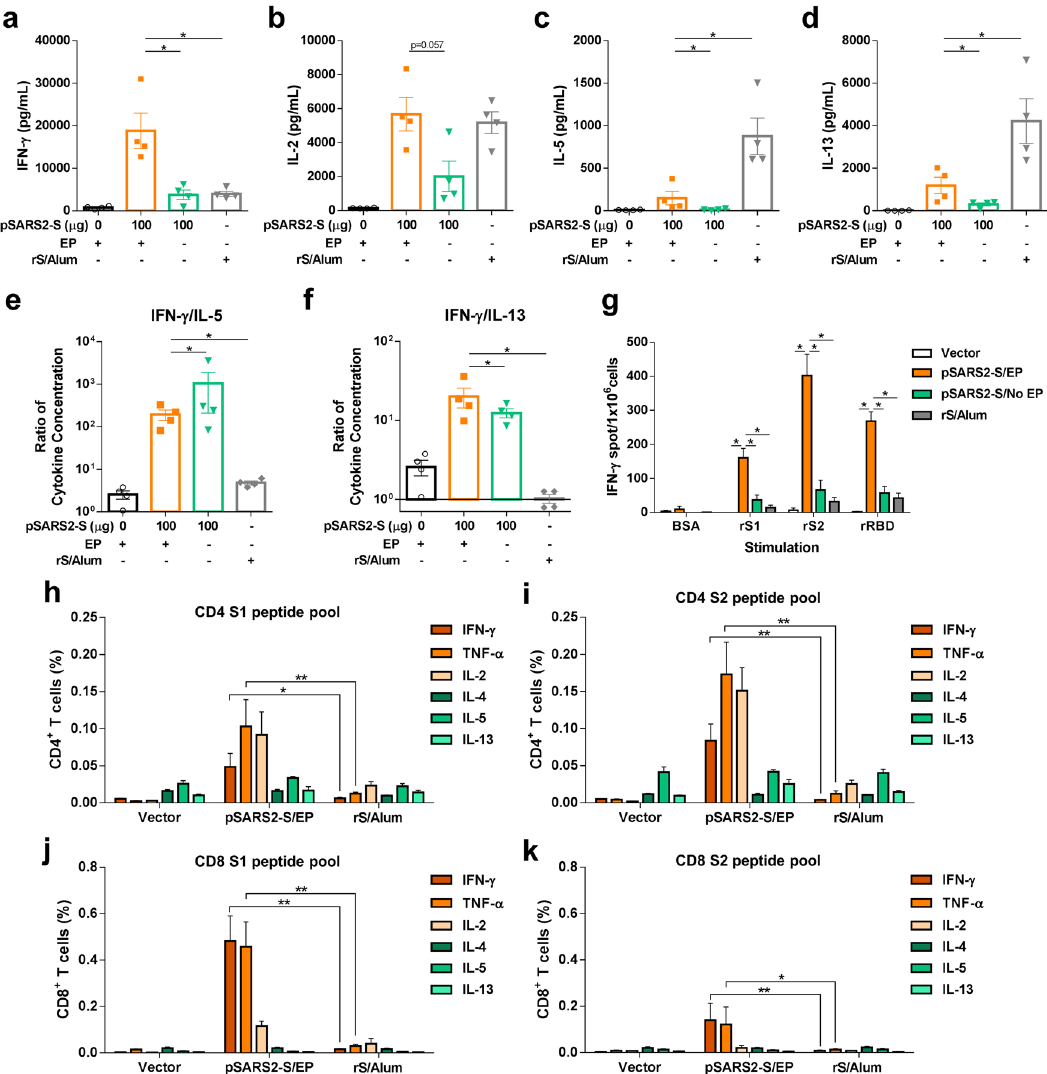
Fig. 2 T cell responses in mice after immunization with pSARS2-S DNA vaccine. BALB/c mice ( n = 4 per group) were intramuscularly immunized twice at a 3-week interval with 100 μ g of vector, 100 μ g of pSARS2-S with 40 Vpp electrostimulation for 5 s (pSARS2-S/EP), pSARS2- S without electrostimulation (pSARS2-S/No EP), or 10 μ g of recombinant spike protein adjuvanted with 150 μ g aluminum hydroxide (rS/Alum). Splenocytes were collected at week 5 after the fi rst immunization, and the levels of secreted IFN- γ , IL-2, IL-5 and IL-13 ( a – d ) were evaluated after restimulation with recombinant spike protein. e, f The ratio of IFN- γ to IL-5 and the ratio of IFN- γ to IL-13 were calculated. g Speci fi c IFN- γ - secreting T cells were also analyzed by IFN- γ ELISpot in splenocytes following stimulation with the indicated recombinant proteins for 48 h. h – k Cytokine expression of spike-speci fi c CD4 + and CD8 + memory T cells. Splenocytes were collected as mentioned above and stimulated with two pools of overlapping peptides spanning the entire spike protein for 6 h. Analyzed cells were gated on CD44 hi /cytokine + for the memory T population. Percentage of memory CD4 + T cells producing IFN- γ , TNF- α , IL-2, IL-4, IL-5 and IL-13 in response to S1 ( h ) and S2 ( i ) peptide pools. Percentage of CD8 + memory T cells producing IFN- γ , TNF- α , IL-2, IL-4, IL-5 and IL-13 in response to the S1 ( j ) and S2 ( k ) peptide pools. The values are presented as the mean ± SEM. * p < 0.05, ** p < 0.01 by the Mann – Whitney